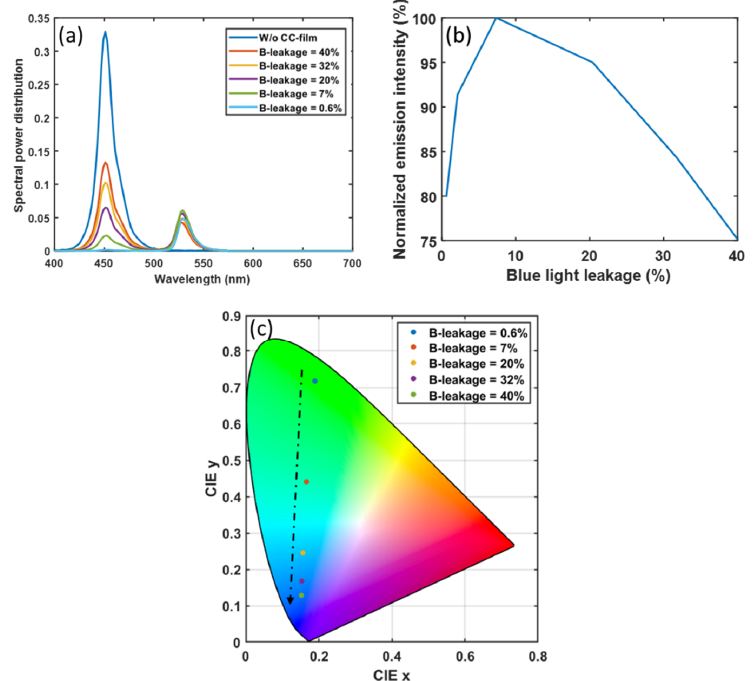
Figure 5. Impact of leaked blue light on ( a ) the spectral power distribution in the green sub-pixels, ( b ) the intensity of down-converted green light, and ( c ) the corresponding color coordinates in CIE 1931.